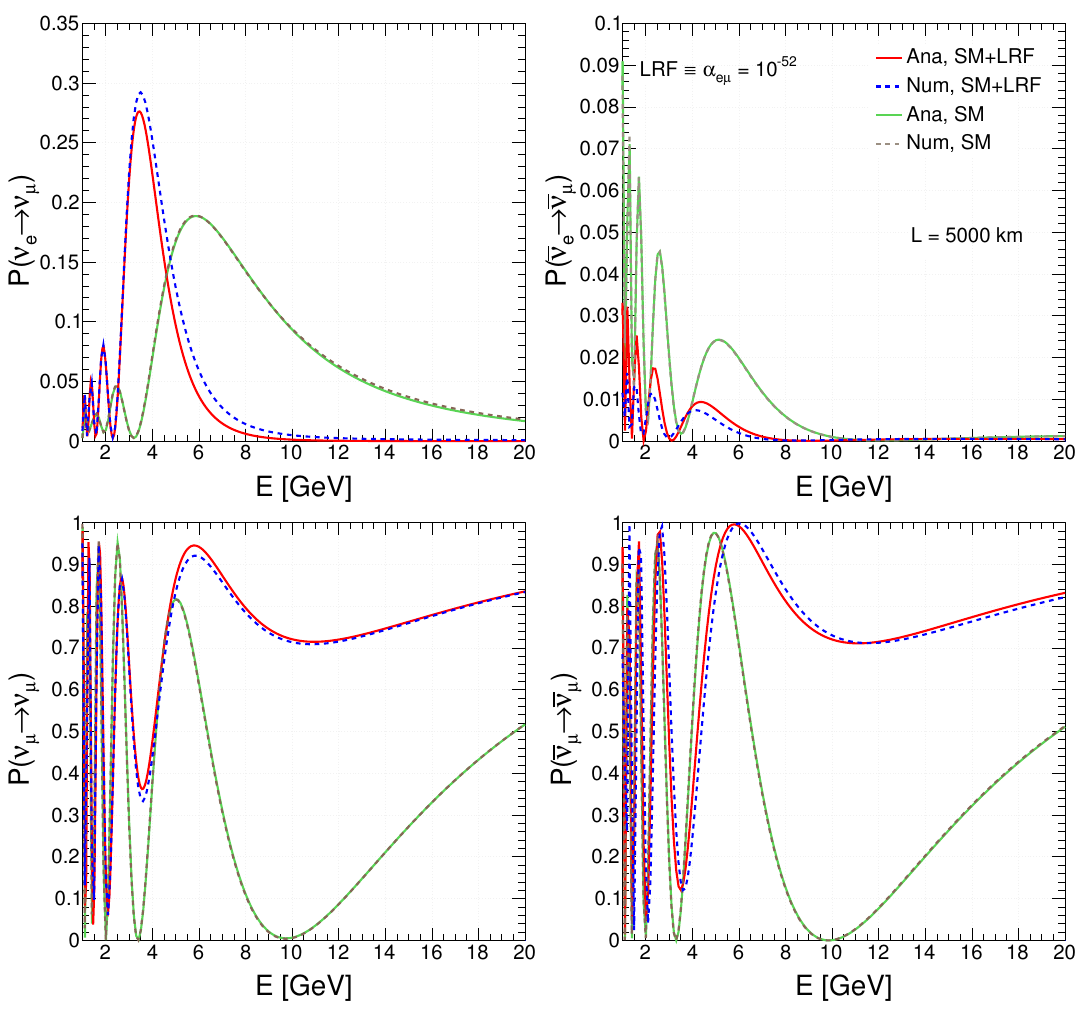
Figure 12 . (cid:23) e ! (cid:23) (cid:22) ((cid:22) (cid:23) e ! (cid:22) (cid:23) (cid:22) ) transition probability for 5000 km in upper left (right) panel assuming NH. In bottom left (right) panel, we show (cid:23) (cid:22) ! (cid:23) (cid:22) ((cid:22) (cid:23) (cid:22) ! (cid:22) (cid:23) (cid:22) ) survival probability. In all the panels, we compare our analytical expressions (solid curves) to the exact numerical results (dashed curves) for the SM and SM + LRF cases. For LRF, we consider (cid:11) e(cid:22) = 10 (cid:0) 52 . Note that the y-axis ranges are di(cid:11)erent in the upper left and right